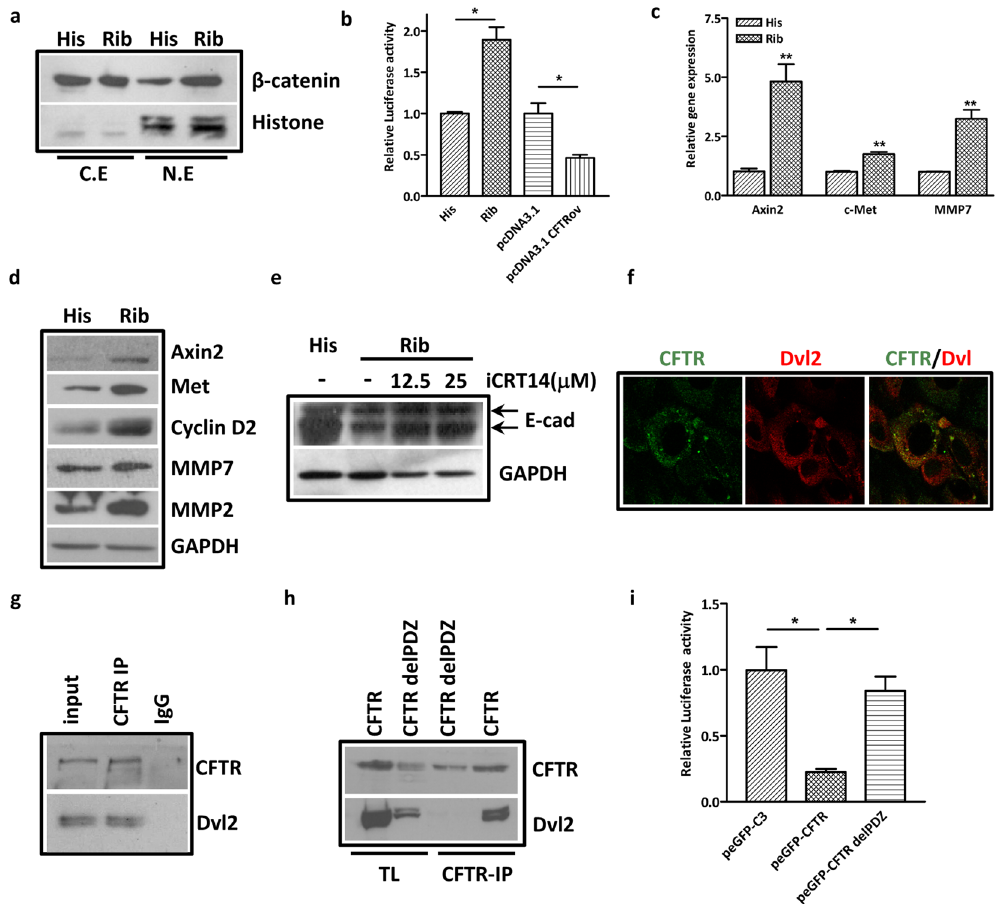
Figure 4. Suppression of CFTR activates β -catenin signaling pathway by interacting with DVL-2 in renal epithelial cells. ( a ) Western blot showing the increased nuclear accumulation of β -catenin in ribozymes- mediated CFTR knockdown HK-2 cells (Rib) comparing to control cells (His) transfected with control vectors (pEF6/V5-His); (N.E-nuclear extraction; C.E-cytoplasmic extraction. (Full-length blot is shown in Supplementary Figure S7g.) ( b ) luciferase activity assay showing knockdown of CFTR increases β -catenin transcriptional activity whereas overexpression of CFTR (pcDNA3.1 CFTRov) decreases β -catenin activity in HK-2 cells. Cells were lysed at 48 hours after transfected with TOPflash reporter gene (0.5 μ g/ml) and Renilla- Luc (0.05 μ g/ml) and the relative luciferase activity was defined as the ratio of readout for firefly luciferase to that for renilla luciferase with that of control group set as 1.0. * p < 0.05; ( c ) Real time-PCR showing increased mRNA expression of β -catenin target genes in CFTR knockdown HK-2 cells, ** p < 0.01; ( d ) Western analysis showing increased protein expression of β -catenin target genes in the CFTR knockdown HK-2 cells. CFTR knockdown HK-2 cells (Rib) comparing to control cells (His) transfected with control vectors (pEF6/V5-His); (Full-length blot is shown in Supplementary Figure S7h.) ( e ) Western blot analysis shows that iCRT14 reverses decreased expression of E-cadherin in a dose-dependent manner in CFTR knockdown HK-2 cells; (Full-length blot is shown in Supplementary Figure S7i.) ( f ) Immunofluorescent staining showing the co-localization of CFTR and Dvl2 in HK-2 cells; ( g ) Co-immunoprecipitation showing the interaction of CFTR and Dvl2 in HK2 cells; (Full-length blot is shown in Supplementary Figure S7j.) ( h ) CO-IP of exogenous CFTR and Dvl2 in HEK293 cells showing lack of interaction when CFTR PDZ-binding domain is deleted; (TL: total cell lysates; full-length blot is shown in Supplementary Figure S7k.) (i) luciferase activity assay shows that overexpression of CFTR wild type (peGFP-CFTR), but not CFTR with deleted PDZ-binding domain (peGFP-CFTR delPDZ), increases β -catenin transcriptional activity in HK-2 cells. Cells were lysed at 48 hours after transfected with TOPflash reporter gene (0.5 μ g/ml) and Renilla-Luc (0.05 μ g/ml) and the relative luciferase activity was defined as the ratio of readout for firefly luciferase to that for renilla luciferase with that of control group set as 1.0. * p <